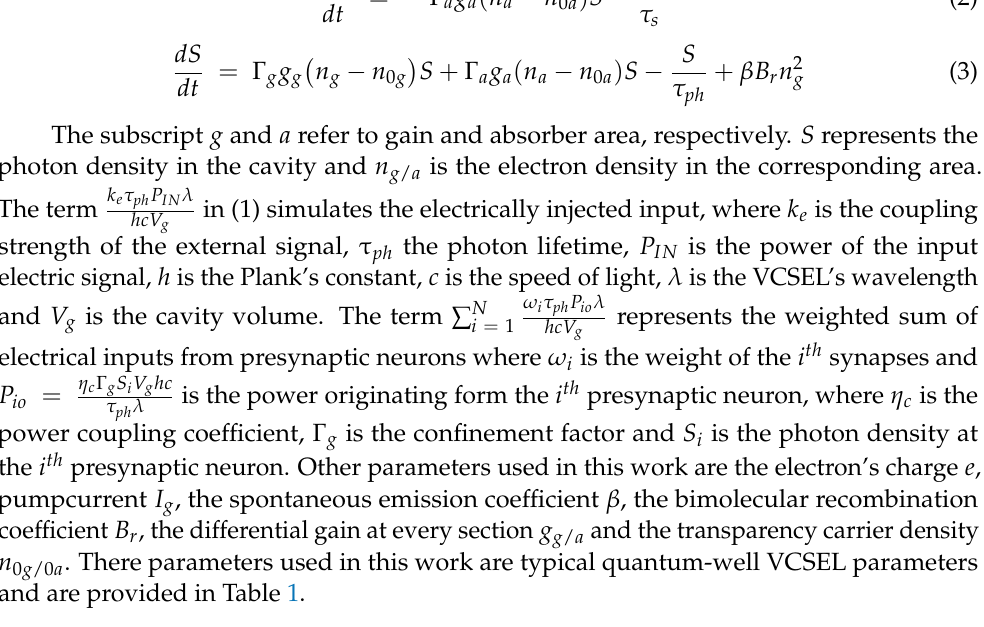
Table 1. Typical vertical cavity surface emitting lasers (VCSEL) parameters used in the simulation. Parameter Gain Section Absorber Section Cavity Volume V g,a Confinement factor Γ g,a 0.06 0.05 Carrier Lifetime τ g,a 1 ns 100 ps Differential gain/loss g g,a Carriers at transparency n